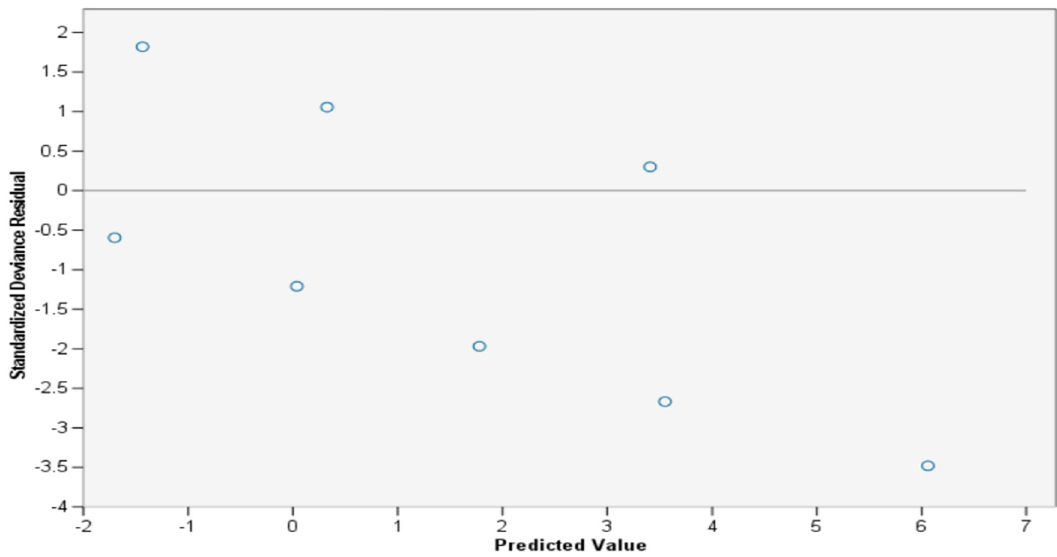
Figure 1: Residual deviance.